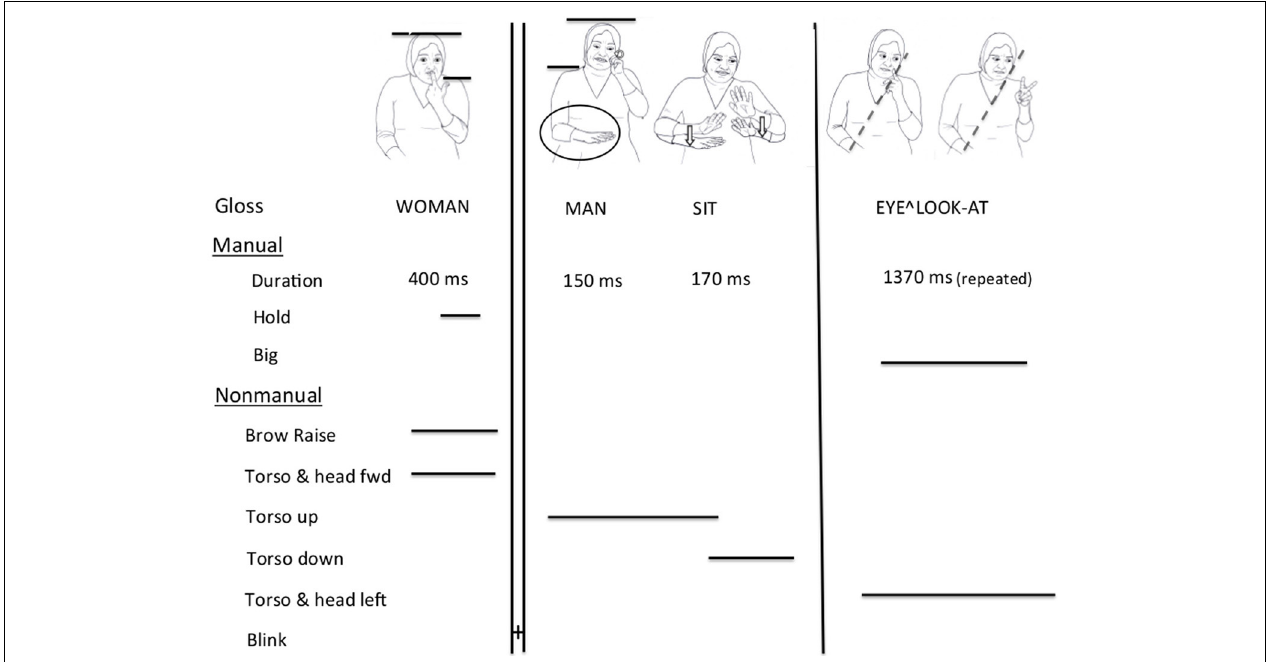
FIGURE 7 | Lexical and prosodic analysis of